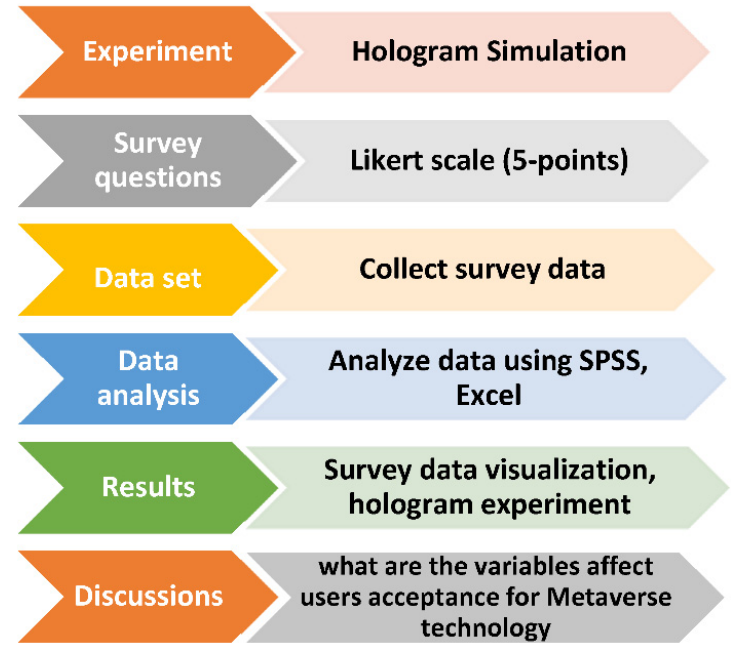
Figure 2. A five steps research methodology.